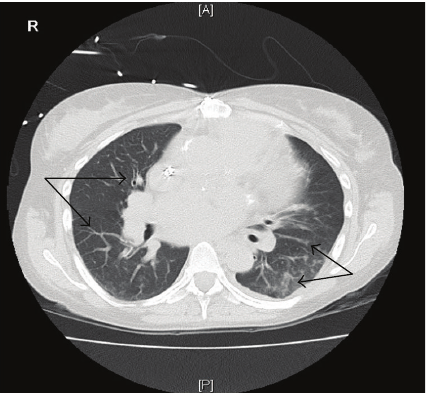
Figure 2: CT scan of the chest showing bilateral lungs ground-glass and tree-in-bud